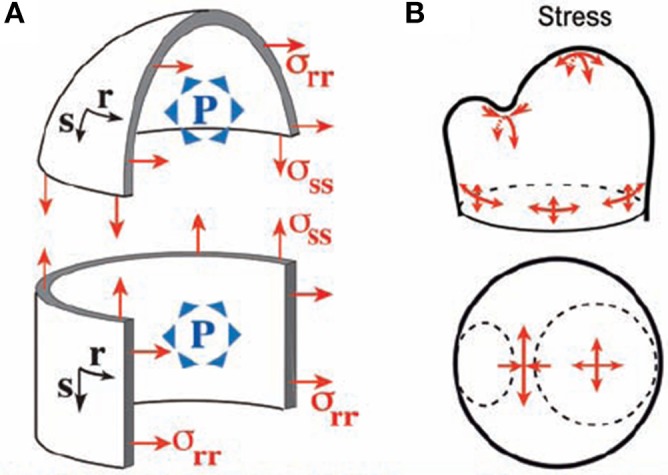
The thin-walled pressurized vessel model of the shoot apical meristem. Integrative structural mechanics (ISM) model used to analyze the loading of the SAM by internal turgor pressure, using very thin shell theory (Hamant et al., 2008), reprinted with permission from AAAS. (A) The SAM modeled as a pressurized vessel. Each point has a coordinate in the orthoradial (r) and meridional (s) direction and P is pressure. (B) At the top of the apical dome, represented as a spherical dome, the stress is isotropic. If the flanks of the meristem are represented as a cylinder, the stress is greater in the circumferential (orthoradial) direction than along the meridian and strongly anisotropic stresses occurrs on the flanks of the meristem. Maximal stress anisotropy occurs at the saddle-shaped boundary between the primordium and the central dome.